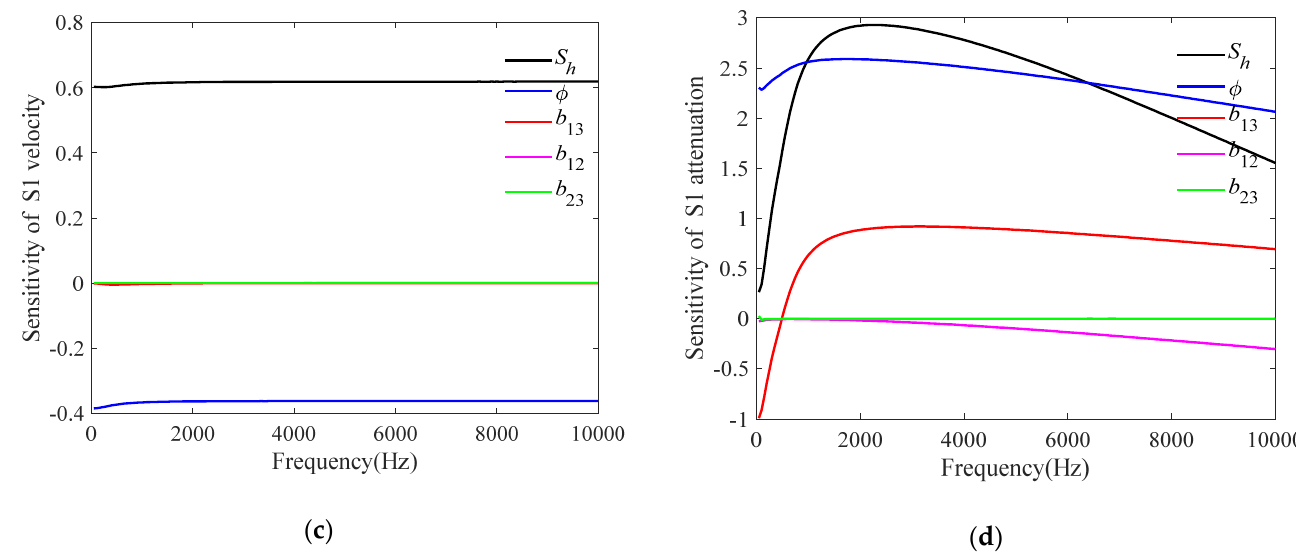
Figure 2. The sensitivities of velocities and attenuations of P1 and S1 to various parameters. Different parameters are involved: gas hydrate saturation, porosity and three friction coefficients between different phases. b 13 is the friction coefficient between solid grains and gas hydrate; b 12 is the friction coefficient between solid grains and pore water; b 23 is the friction coefficient between pore water and gas hydrate: ( a ) P1 velocity; ( b ) P1 attenuation; ( c ) S1 velocity; ( d ) S1 attenuation.